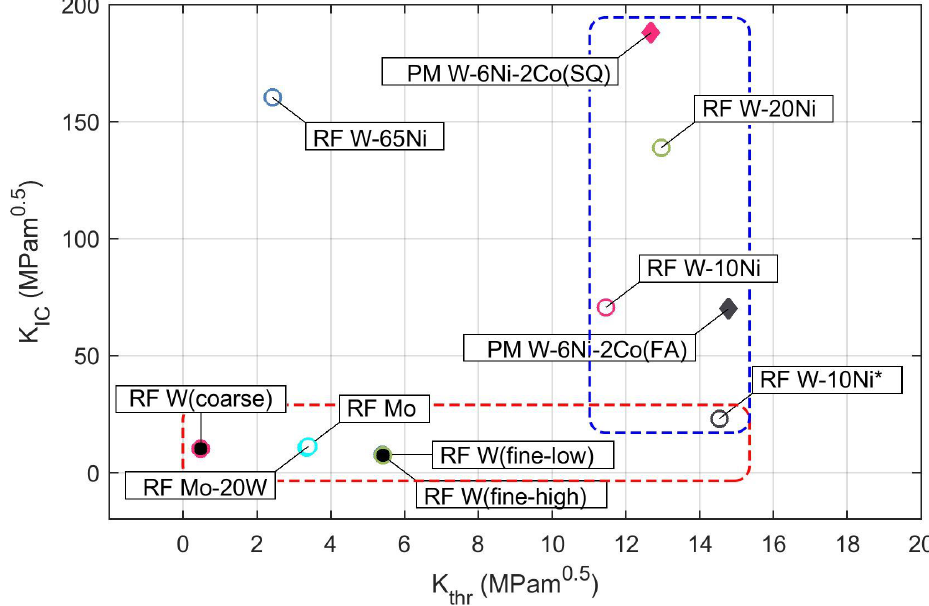
Figure 6. Fatigue crack growth threshold ∆ K thr and fracture toughness K IC of the investigated refractory